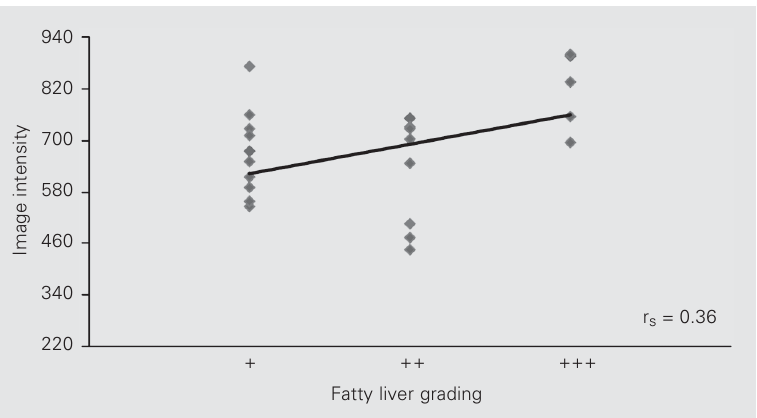
Figure 1. Correlation between conventional magnetic resonance imaging and the histologi- cal grading of hepatic steatosis. Fatty liver was graded as described in Ref. 14: +, up to